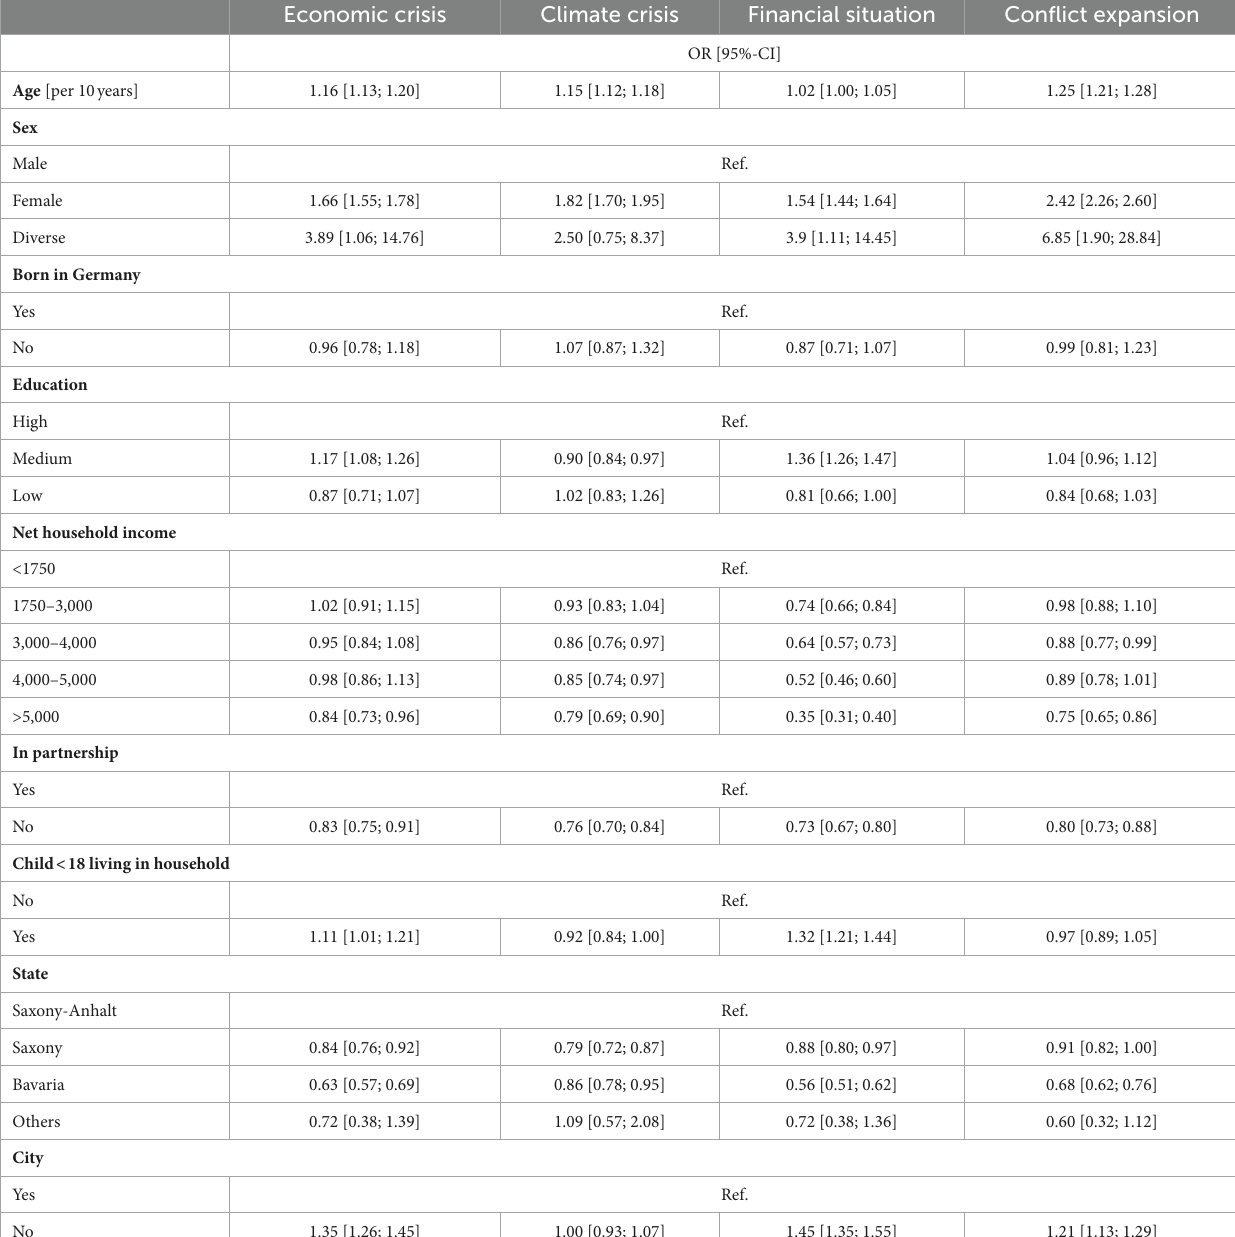
TABLE 3 Multivariable ordinal regression for characteristics associated with specific aspects of